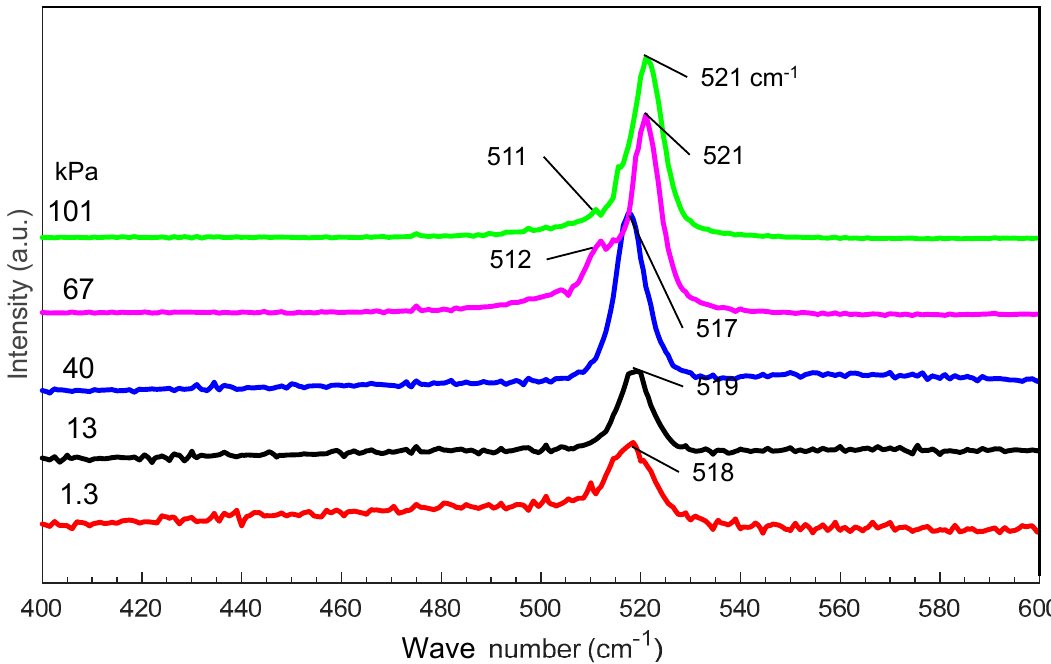
Figure 5. Raman spectra of silicon nanomaterials generated at di ff erent gas pressures.